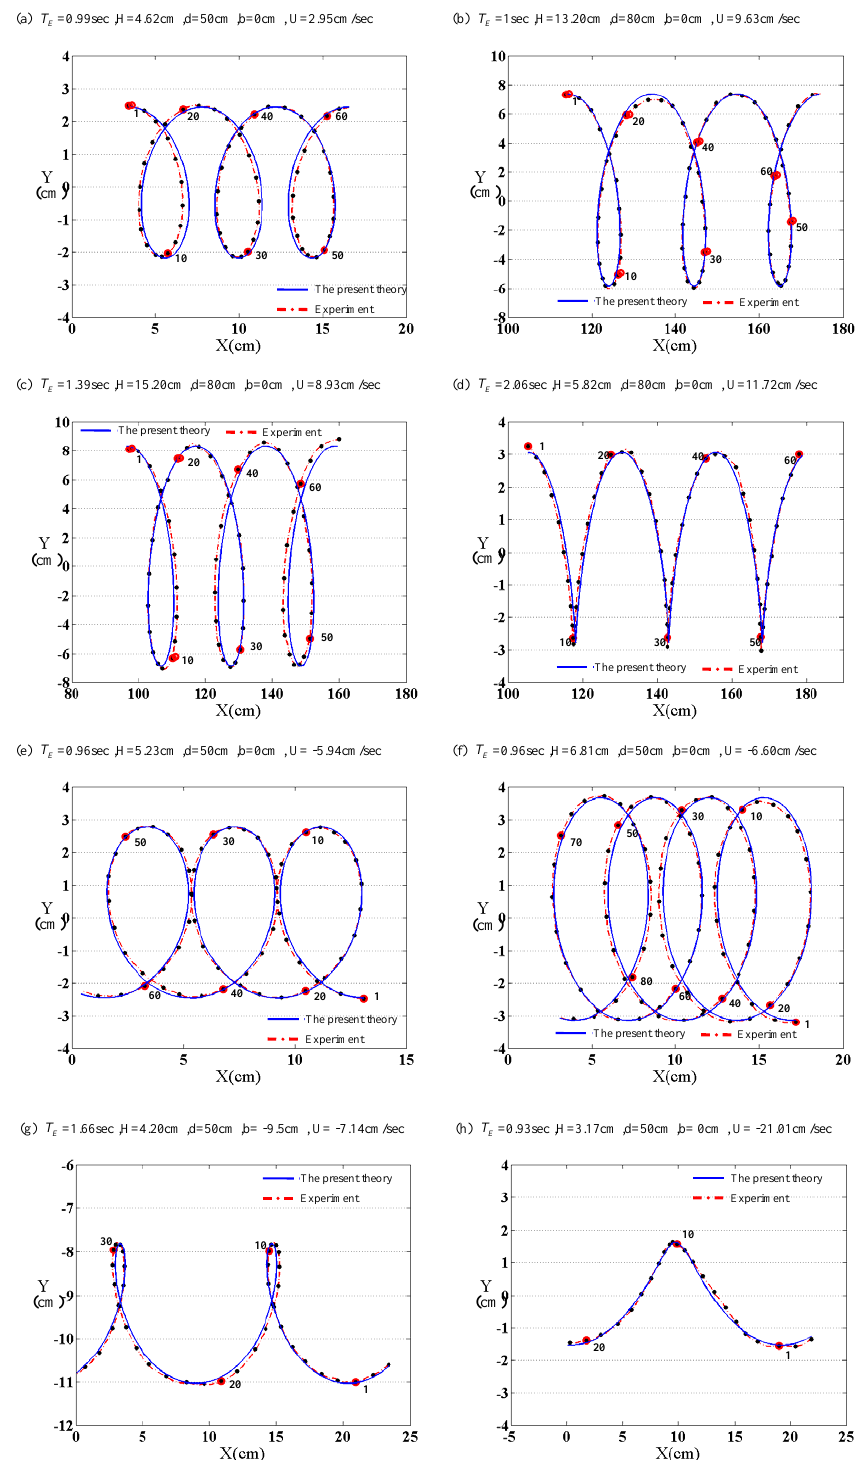
Fig. 5. Comparisons between the orbits of water particles obtained by the presented theory and those from the experimental measurements of the PS motions at different water levels b in the various experimental wave cases, where solid line is the theoretical result and point is the experimental data which the time interval between two adjacent points is T E / 20, T E is the wave period.